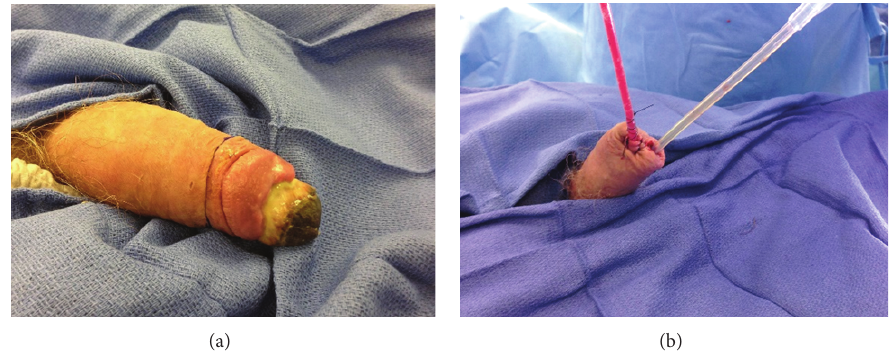
Figure 1: Gross images prior to and following distal penectomy for